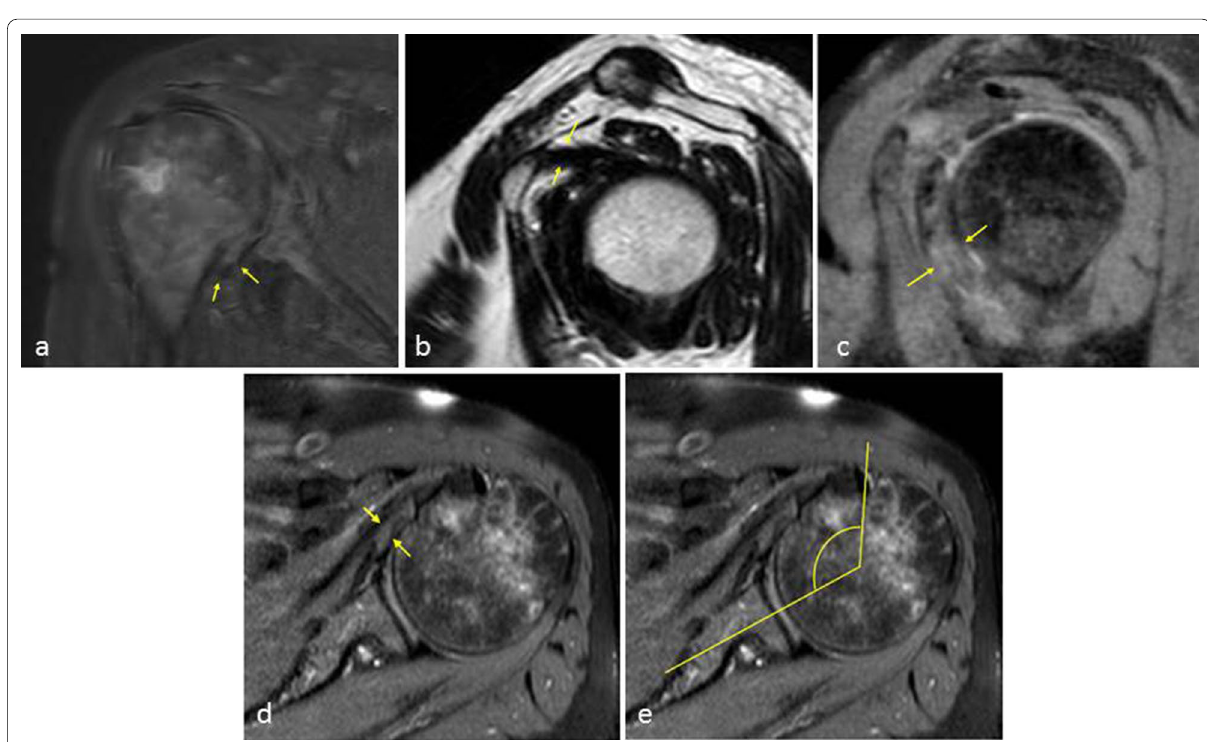
Fig. 7 A 65-year-old female patient with clinically suspected adhesive capsulitis (shoulder pain and limitation of movement). a Oblique coronal fat-sat T2-weighted image demonstrating no sizable increased thickness of the axillary recess (thin yellow arrows). Also there is no gross axillary capsule altered signal intensity. b Oblique sagittal T2-weighted image illustrating a thickened coracohumeral ligament. c Oblique sagittal PD VISTA SPAIR image illustrating thickened and increased signal intensity of the anterior joint capsule (thin yellow arrows). d Axial fat suppressed PD image demonstrating increased thickness (6.95 mm) and increased signal intensity of the anterior shoulder joint capsule (thin yellow arrows). e Same Axial PD fat suppressed weighted image at the level of center of humeral head showing the angle of external